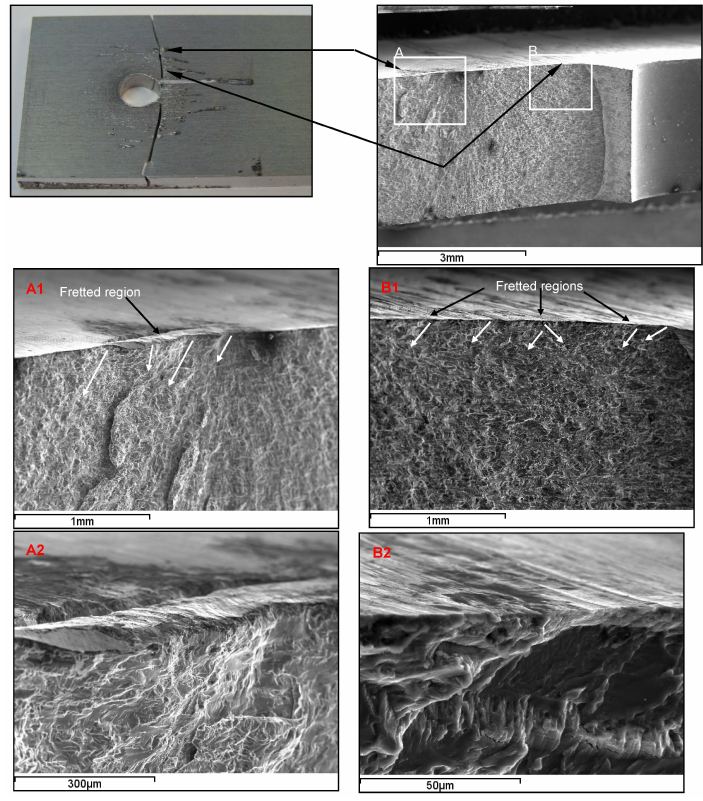
Figure 6. Fretting fatigue damage zones and crack nucleation sites; uncoated Al 7075-T6 plate clamped with T = 5 Nm that failed under S max = 80 MPa. ( A and B ) fretted regions; ( A1 , A2 , B1 and B2 ) fretted regions at higher